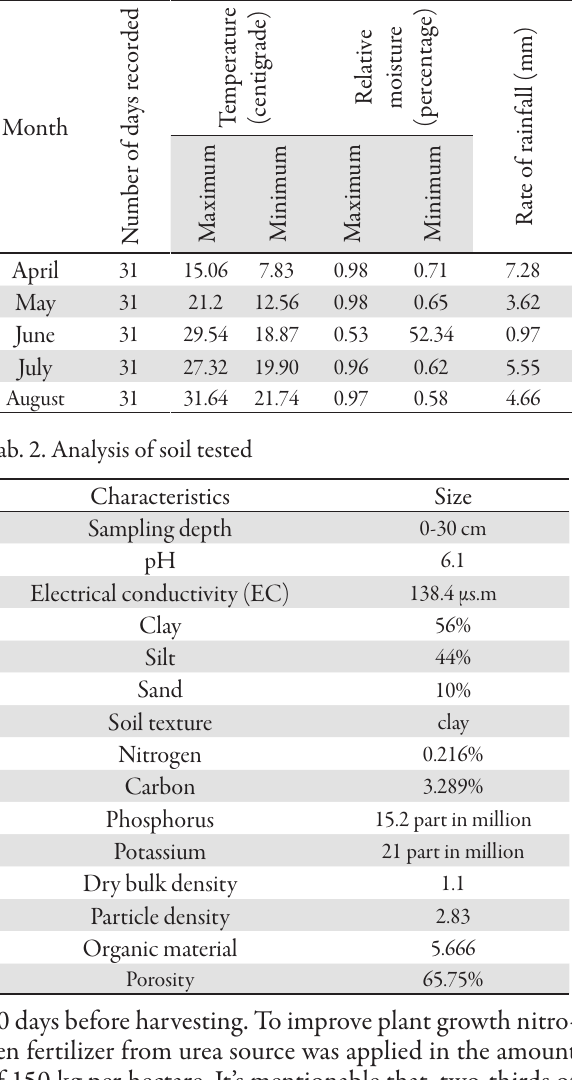
Tab. 1. Meteorological data related to period of rice